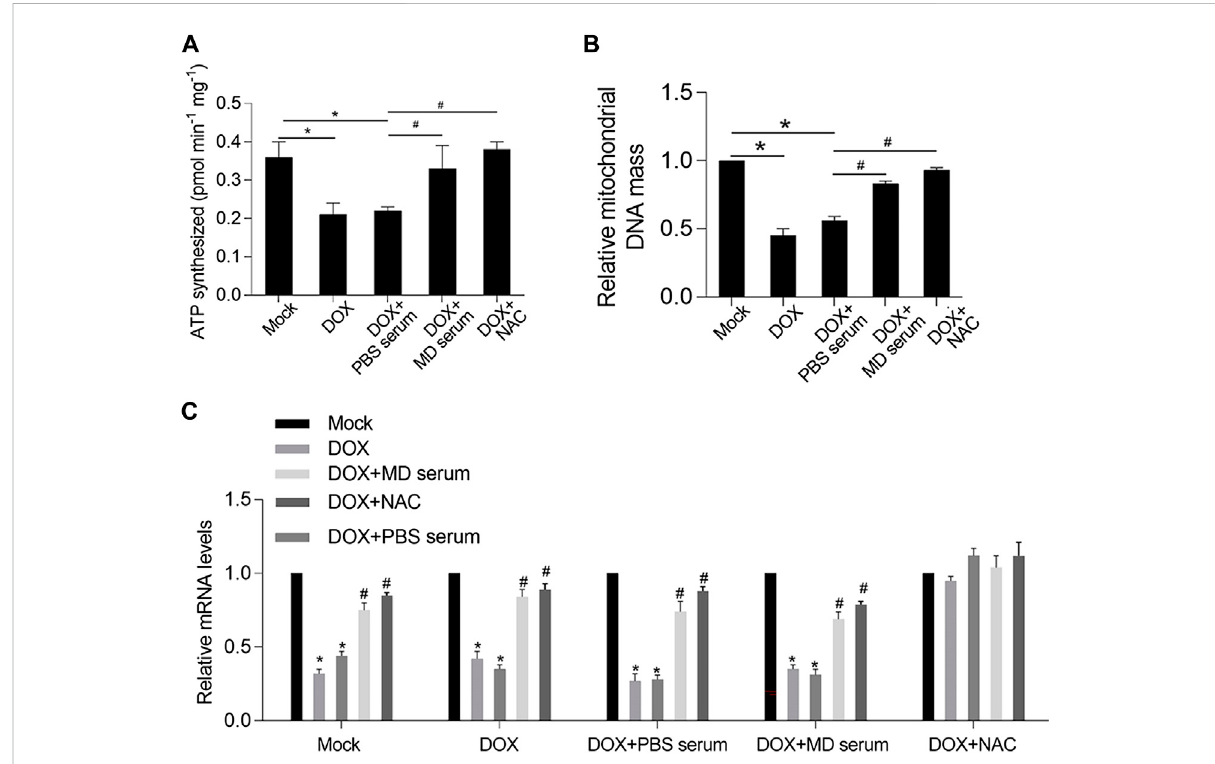
FIGURE 7 YXX keli protected mitochondrial function potentially via decreasing accumulated ROS induced by DOX in RCM. (A) . ATP synthesis was measured. * p < 0.05, mock group; # p < 0.05, DOX + PBS-medicated serum. (B) . Mitochondrial DNA mass was measured by quantitative PCR. * p < 0.05, mock group; # p < 0.05, DOX + PBS-medicated serum. (C) . Mitochondrial transcriptional activity was measured by performing RT-qPCR to detect the expression level of mitochondrial coded